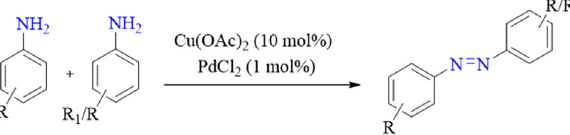
Scheme 1: Palladium salt mediated catalytic synthesis of aromatic azo compounds from